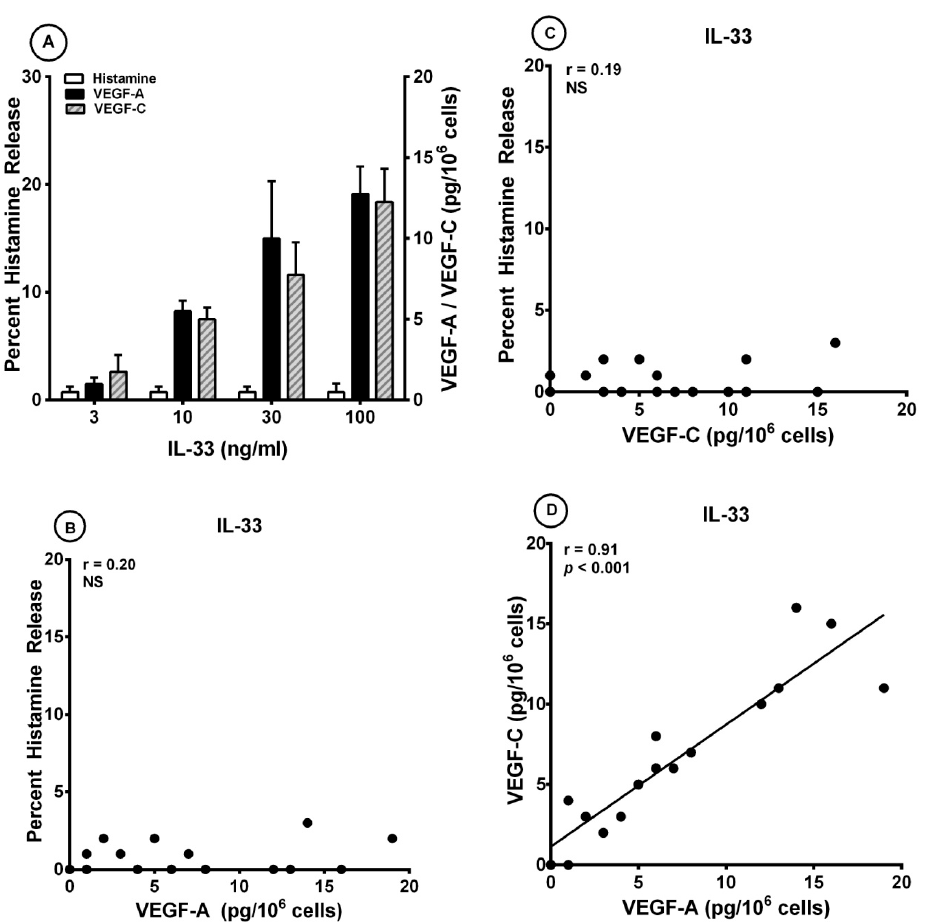
Figure 3. ( A ) Effects of increasing concentrations of IL-33 on histamine release and the production of VEGF-A and VEGF-C from four different preparations of human lung mast cells (HLMCs). HLMCs were incubated (45 min at 37 °C) with the indicated concentrations of IL-33 for histamine secretion or (12 h at 37 °C) for VEGF-A and VEGF-C release. Each bar is the mean ± SEM; ( B ) Lack of correlation (r = 0.20; NS) between VEGF-A release and the percent histamine secretion caused by IL-33 from HLMCs; ( C ) Lack of correlation (r = 0.19; NS) between VEGF-C release and the percent histamine secretion caused by IL-33 from HLMCs; ( D ) Correlation (r = 0.91; p < 0.001) between VEGF-A and VEGF-C release caused by IL-33 from HLMCs.